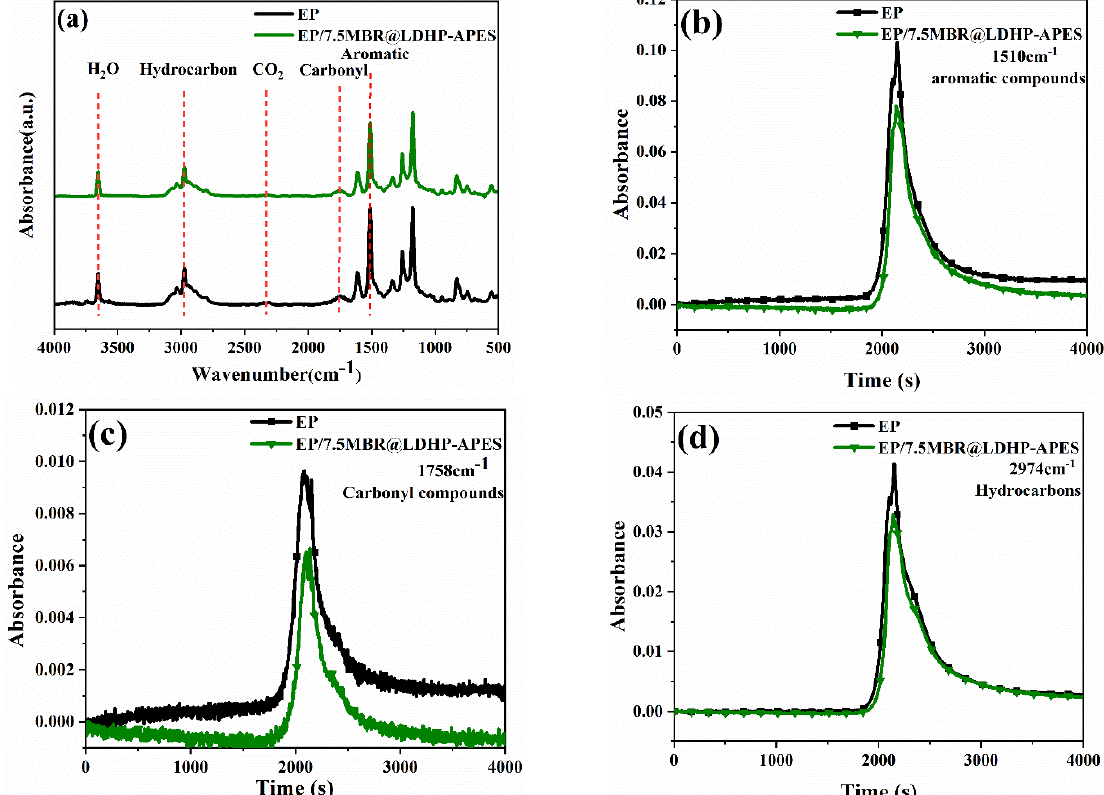
Figure 11. FTIR spectra of EP and EP/7.5MBR@LDHP-APES at the maximal rate of degradation ( a ); The FTIR absorption peak intensity pyrolysis products curve at: ( b ) 1510 cm − 1 , ( c ) 1758 cm − 1, and ( d ) 2974 cm − 1 of EP and EP/7.5 MBR@LDHP-APES over time. 361